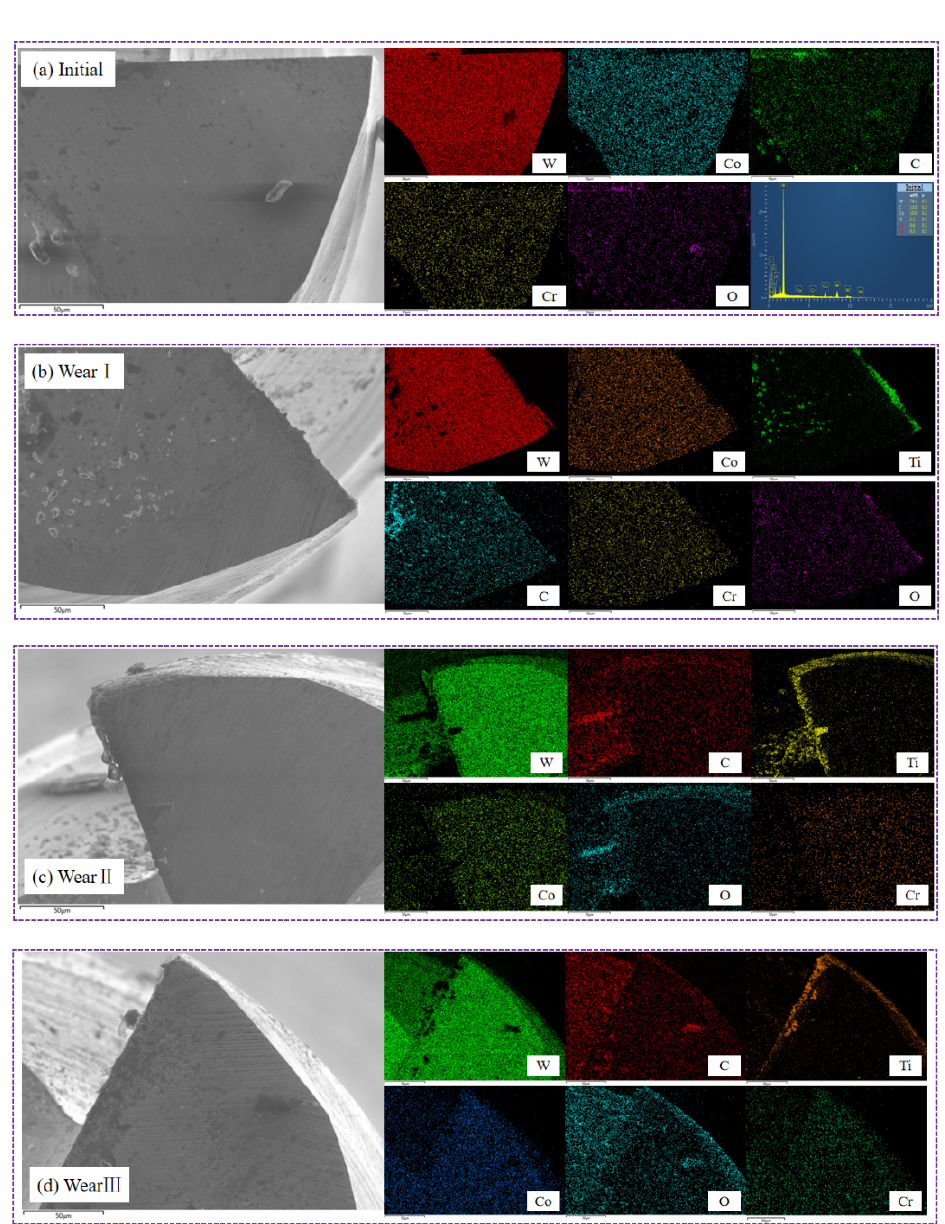
Figure 16. SEM/EDS data of micro milling cutter under different wear states. ( a ) Element distribu- tion of Initial; ( b ) Element distribution of Wear I; ( c ) Element distribution of Wear II; ( d ) Element distribution of Wear III.